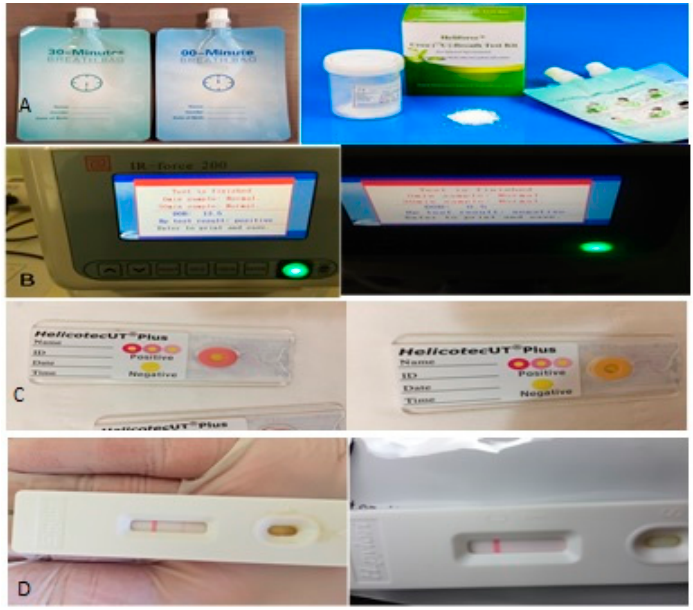
Figure 1. ( A ) The 13 c breath test kit; ( B ) positive and negative 13 C urea breath test; ( C ) positive and negative rapid urease test; ( D ) positive and negative stool antigen test.